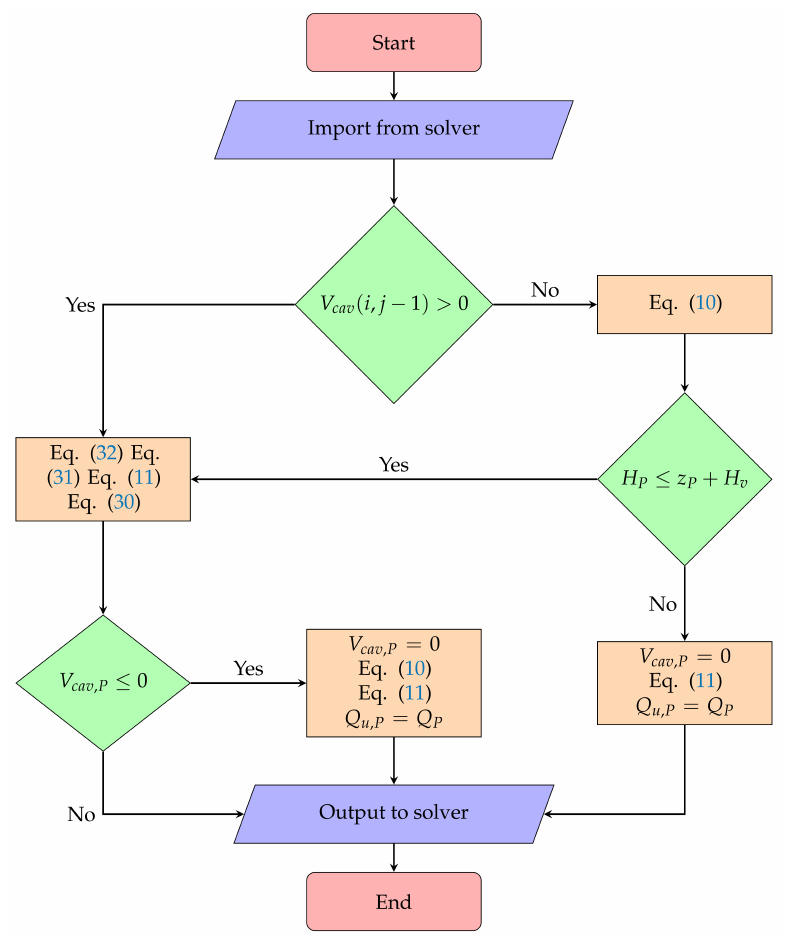
Figure A2. DVCM flow